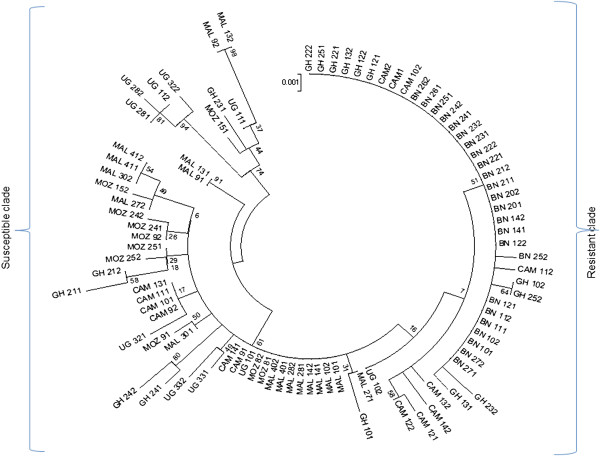
Maximum likelihood phylogenetic tree of GSTe2 (coding and non-coding regions) across Africa. The analysis involved 92 sequences (2n) labeled. All positions with gaps and missing data were eliminated. There were a total of 881 positions in the final dataset. A resistant clade that is less polymorphic and dominated by the Benin population is clearly identifiable to the right of the tree whereas a susceptible clade that is more polymorphic and more cosmopolitan is at the left of the tree. BN, Benin; CAM, Cameroon; GH, Ghana; MAL, Malawi; MOZ, Mozambique; UG, Uganda.